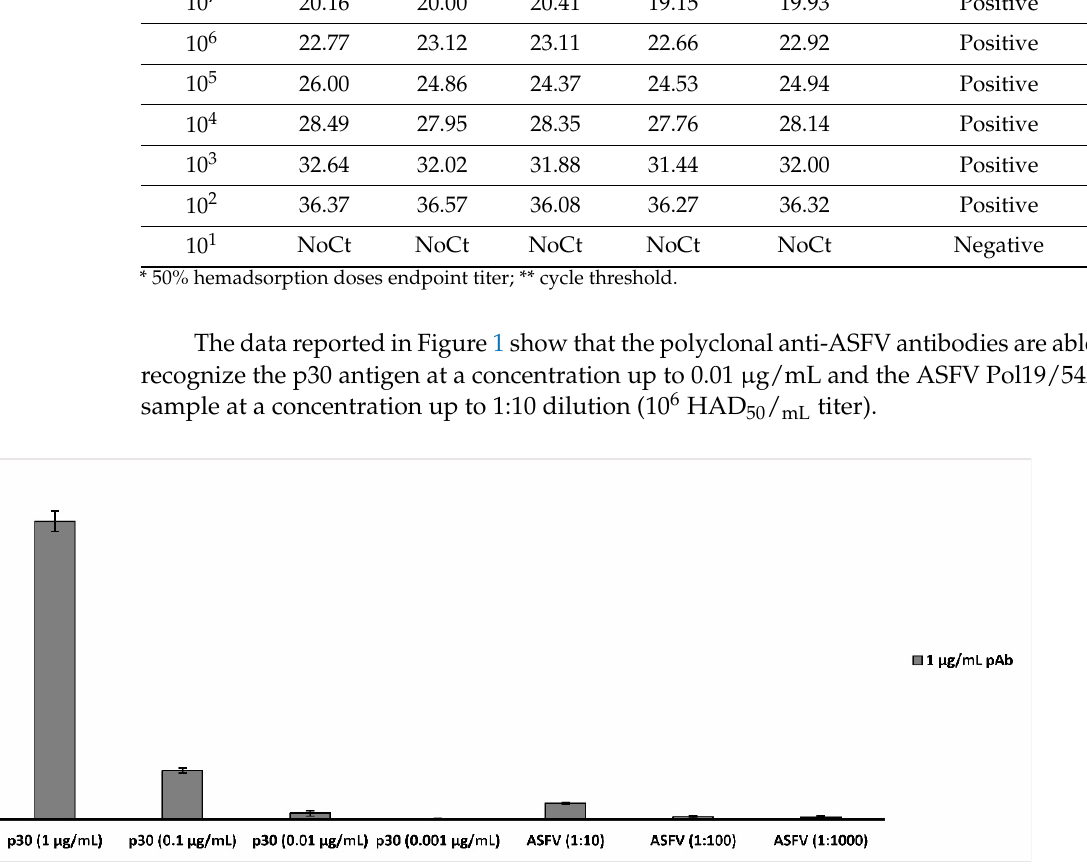
Table 1. The analysis of detection limit of ASFV isolate serial dilutions in real-time PCR. Ct ** Values (Replicates) HAD 50 * Mean Ct **